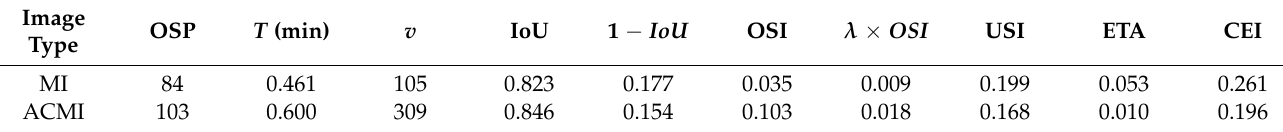
Figure 6. Comparison of EPGSs of MI and ACMI: ( a ) MI; ( b ) ACMI. Table 6. Comparison of segmentation evaluation parameters of MI and